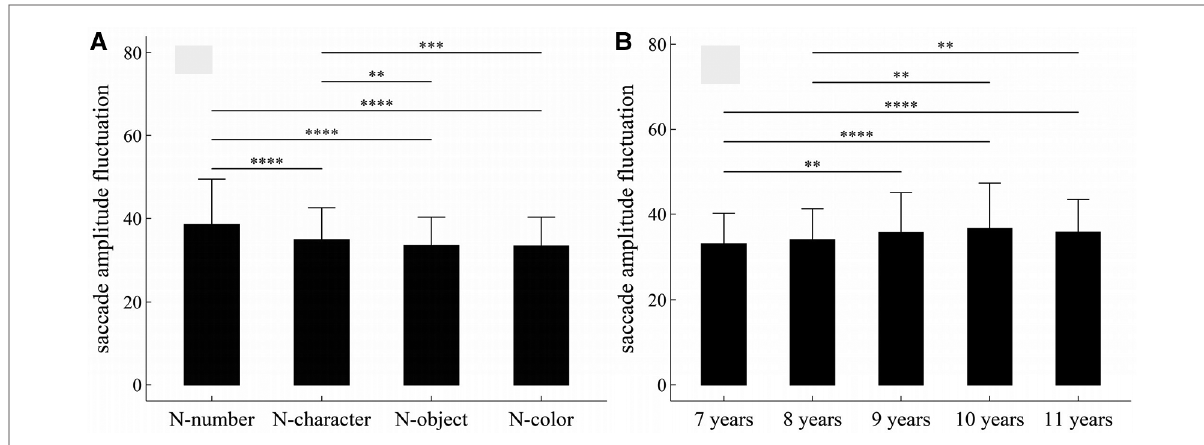
FIGURE 7 In fl uence of task-type, gender and age on saccade amplitude fl uctuation: ( A ) in fl uence of task-type; ( B ) in fl uence of age. * p <0.05; ** p <0.01; *** p < 0.001; **** p <1×10 − 4 .